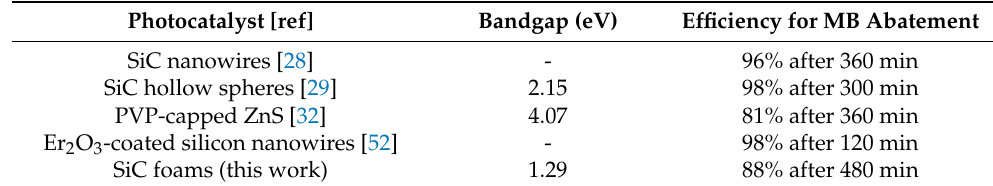
Table 1. Comparison of performance for different photocatalysts under visible light